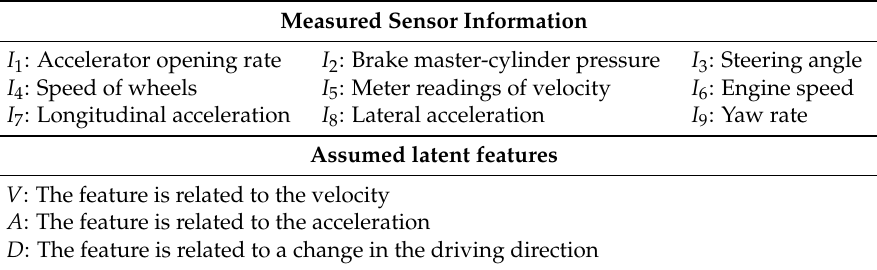
Table 1. Measured sensor information and the assumed latent features of driving